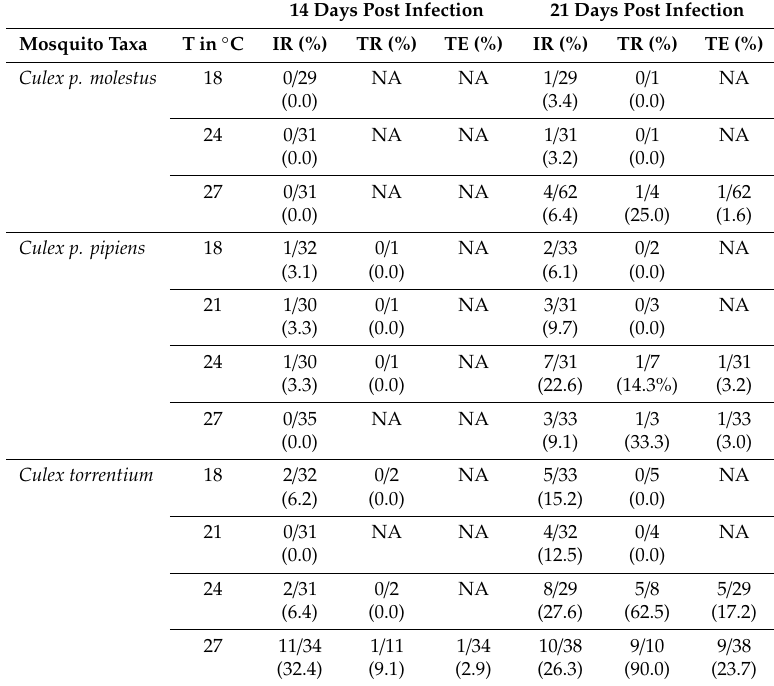
Table 1. Infection (IR), transmission (TR) and transmission e ffi ciency rates (TE) of three Culex species experimentally infected with West Nile virus and kept at four di ff erent temperatures, June 2016 to July 2017 ( n = 788). The experimental analytical sensitivity of the qRT-PCR was analysed according the protocol of Caraguel et al. calculating the limit of detection via endpoint dilution [50]. The limit of detection was defined as 100 copies / µ L, corresponding to about 10,000 copies per mosquito